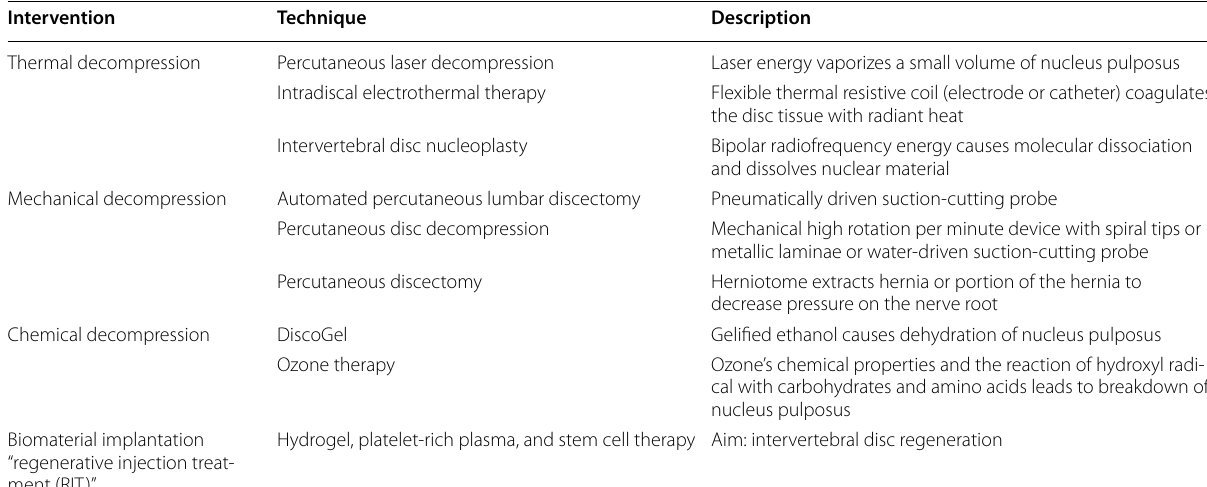
Table 1 Percutaneous interventional disc procedures (Santiago et al. [75])